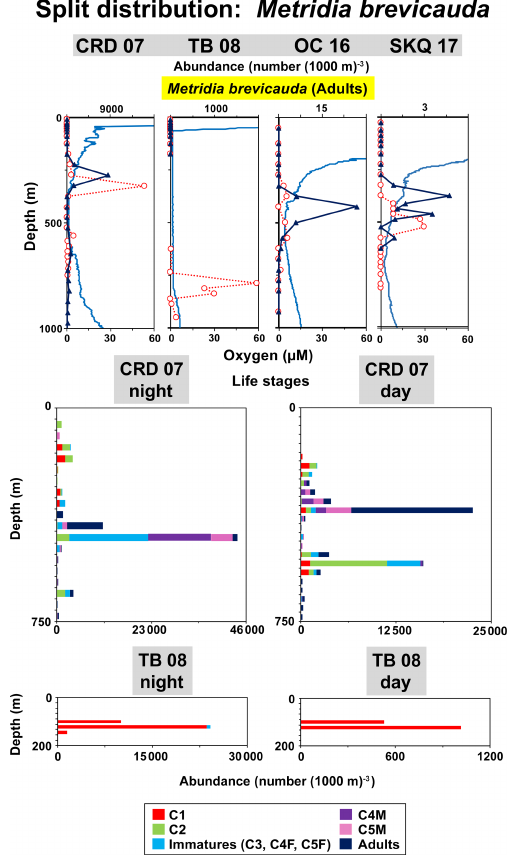
Figure 6. Vertical distributions relative to oxygen for Metridia bre- vicauda (adults) at each station (top row). Second and third rows: life history stage distributions (color-coded bar graphs) are shown for CRD in 2007 night and day (to 750m, the deepest depth with both night and day abundance data) and for TB in 2008 for the up- per water column (0–200m, the only depth range with life history stage counts for that cruise) night and day. Abundance axes vary. Bars are plotted by sample order with increasing depth. See the ver- tical profiles (top row) and Tables 1 and S1 (Wishner et al., 2019) for depth ranges for each net and Table 3 for the DMA. See Fig. 3 caption for more explanation of the vertical profiles.